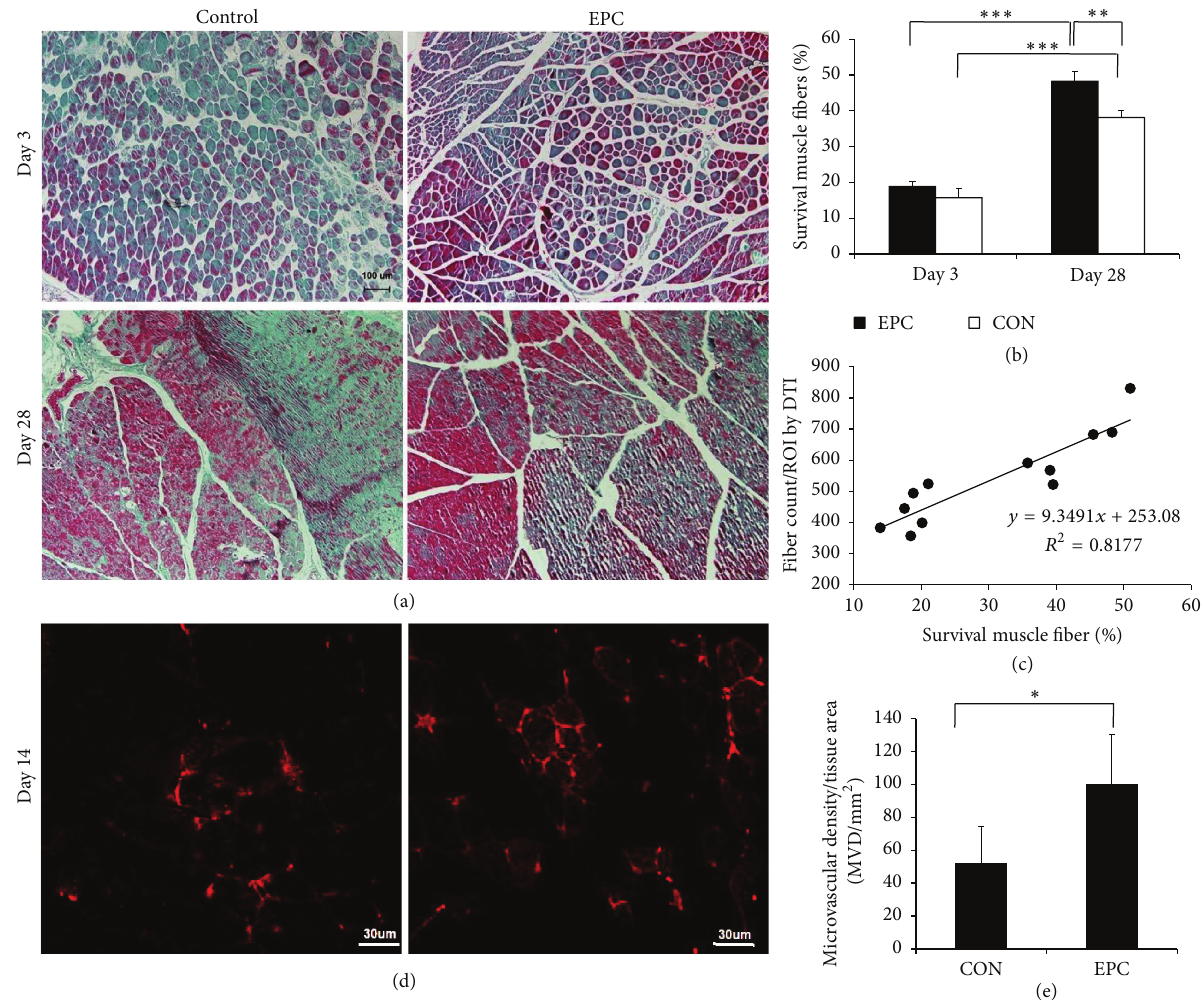
Figure 6: Histologic specimens obtained from ischemia muscle. (a) At days 3 and 28, almost complete tissue recovery using Masson’s staining was found in the EPCs treated group. However, in the control group, multiple inflammations and collagen were found (bar = 100 𝜇 m). (b) A bargraphshowedthatthesurvivalmusclefibersofmicetreatedwithEPCsweregreaterthanwiththecontrolgroup. Dataisexpressedasmean ± SD, ∗ 𝑃 < 0.05 . (c) A line graph showed the correlations between survival muscle fibers by histological method and fiber count measured by DTI ( 𝑟 = 0.874 , 𝑃 < 0.01 ). (d) The microvascular density was measured by staining ischemia tissues with CD31 on day 14 after treatment. The EPC treatment augmented vessel density of the ischemic hindlimb (bar = 30 𝜇 m). (e) A bar graph showed that the microvascular density (MVD) in the group treated with EPCs was significantly increased compared with that of the control group. ∗ 𝑃 < 0.05 , ∗∗ 𝑃 < 0.01 , and ∗∗∗ 𝑃 < 0.001